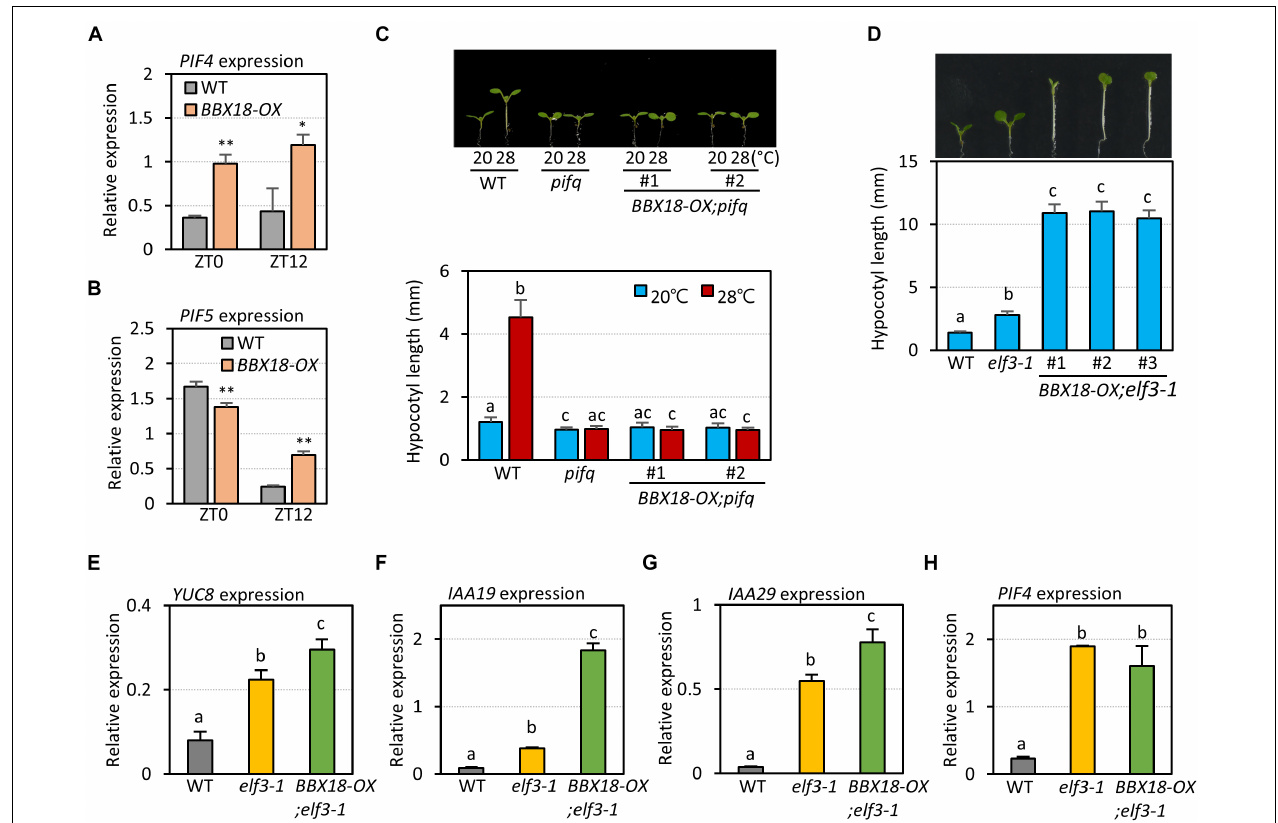
FIGURE 3 | BBX18-mediated promotion of hypocotyl growth is dependent on PIFs, but not on ELF3. qRT–PCR analyses to check for the expression of PIF4 (A) and PIF5 (B) . Wild-type (WT) and BBX18-OX plants were grown in 12 h light/12 h dark cycles (12L:12D) at 20 ◦ C for 4 days. On the 5th day, the plants were harvested at ZT0 and ZT12 for RNA extraction. The expression of target genes was normalized to that of PP2A . Error bars indicate SD ( n = 3). * P < 0.05 and ** P < 0.01 (Student’s t -test). (C) Hypocotyl lengths of WT, pifq , and BBX18-OX;pifq seedlings grown under continuous white light at 20 ◦ C for 7 days (20 ◦ C) or 20 ◦ C for 4 days followed by 28 ◦ C for 3 days (28 ◦ C). Letters above the bars indicate significant differences based on one-way ANOVA and Tukey’s test ( P < 0.05). (D) Hypocotyl lengths of WT, elf3-1 , and BBX18-OX;elf3-1 seedlings grown under continuous white light at 20 ◦ C for 7 days. Letters above the bars indicate significant differences based on one-way ANOVA and Tukey’s test ( P < 0.05). qRT–PCR analyses to check for the expression of YUC8 (E) , IAA19 (F) , IAA29 (G) , and PIF4 (H) . WT, elf3-1 , and BBX18-OX;elf3-1 #1 plants were grown in 12 h light/12 h dark cycles (12L:12D) at 20 ◦ C for 4 days. On the 5th day, the plants were harvested at ZT0 for